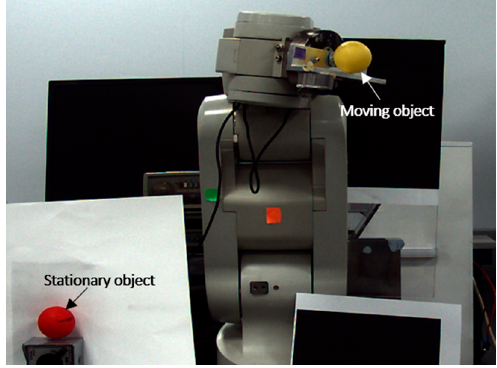
Figure 15. Setup for the still target in the uncertainty test. Table 6. Position estimation uncertainty for a still target.